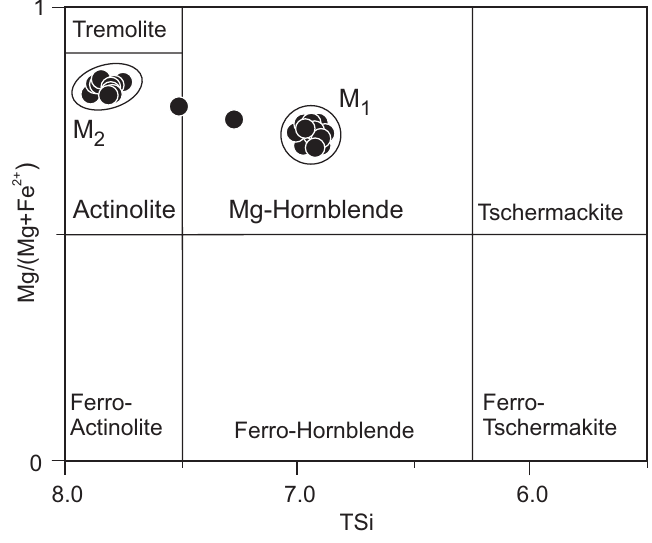
Fig. 4 – M 1 hornblende and M 2 actinolite compositions from the investigated sample. Two analyses are intermediate between the two extreme compositions because of partial resetting during greenschist facies metamorphic